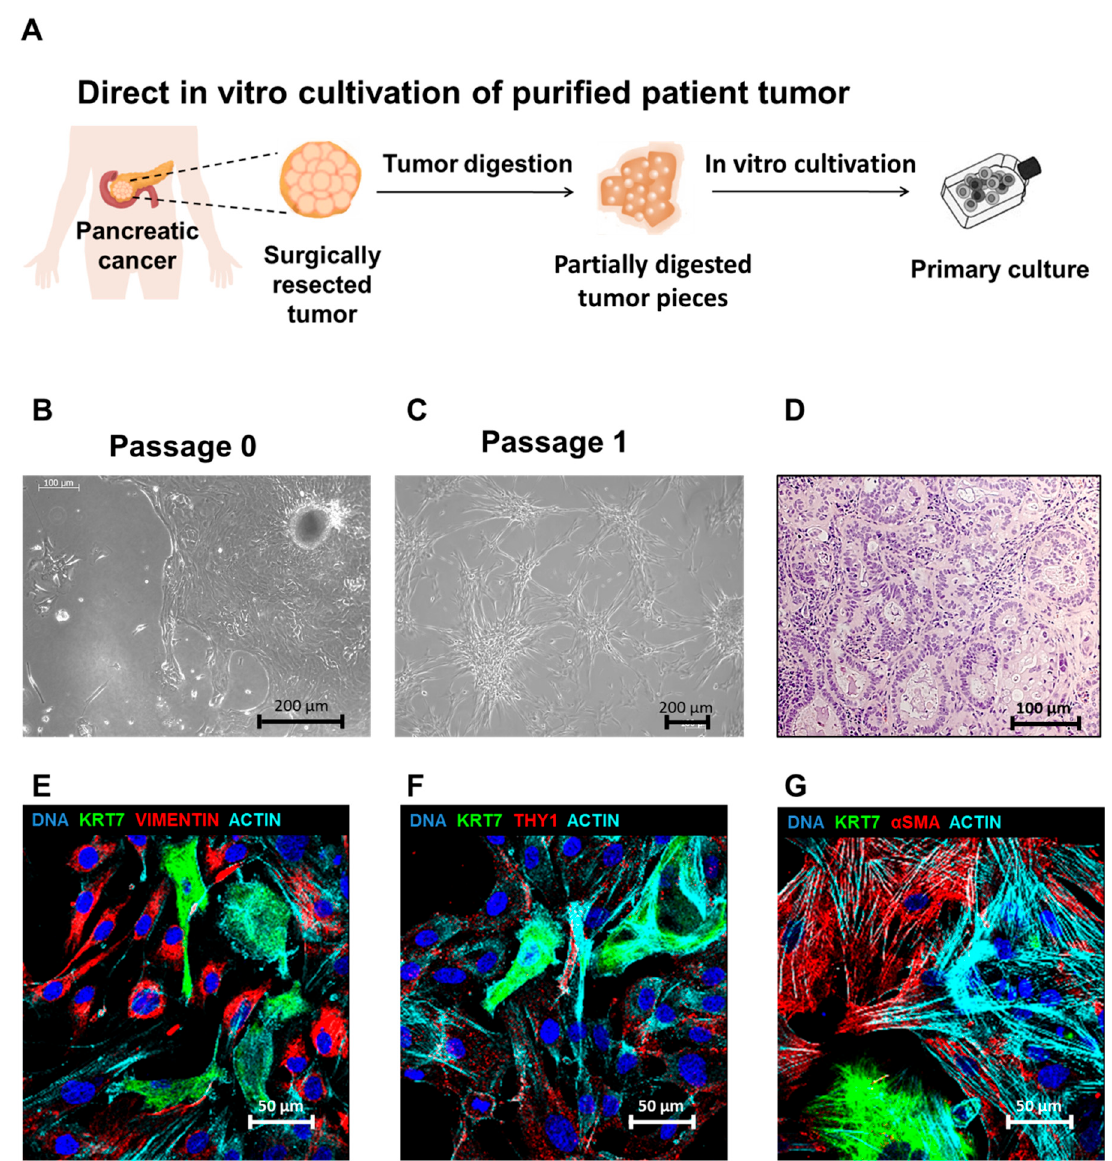
Figure 1. Cultivation of pancreatic tumor cells directly after resection of patient tumors. ( A ) Following surgery, pancreatic cancer tissue was minced and enzymatically digested. The partially digested tumor pieces were plated in cell culture flasks for culture establishment. ( B ) Primary tumor cells grew out from the tumor pieces and grew as epithelial colonies. ( C ) Following passaging, the epithelial cells gradually were lost and were overgrown by fibroblast-like cells. ( D ) Xenograft tumor derived from the cell culture established directly from surgically resected cancer tissue displayed adenocarcinoma histology. ( E – G ) Outgrowth cultures established directly from surgically resected tumor pieces expressed the pancreatic duct marker Cytokeratin 7 (KRT7), mesenchymal stroma markers vimentin ( E ), THY1 ( F ) and α -smooth-muscle actin ( α SMA, red) together with actin (cyan) ( G ). ( B , C ) Representative data of PC42 is shown, ( D – G ): representative data of PC2 are shown.